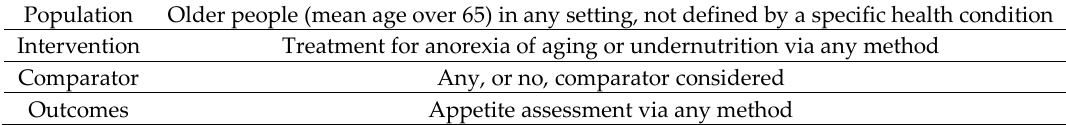
Figure 2. PICO statement for study inclusion.